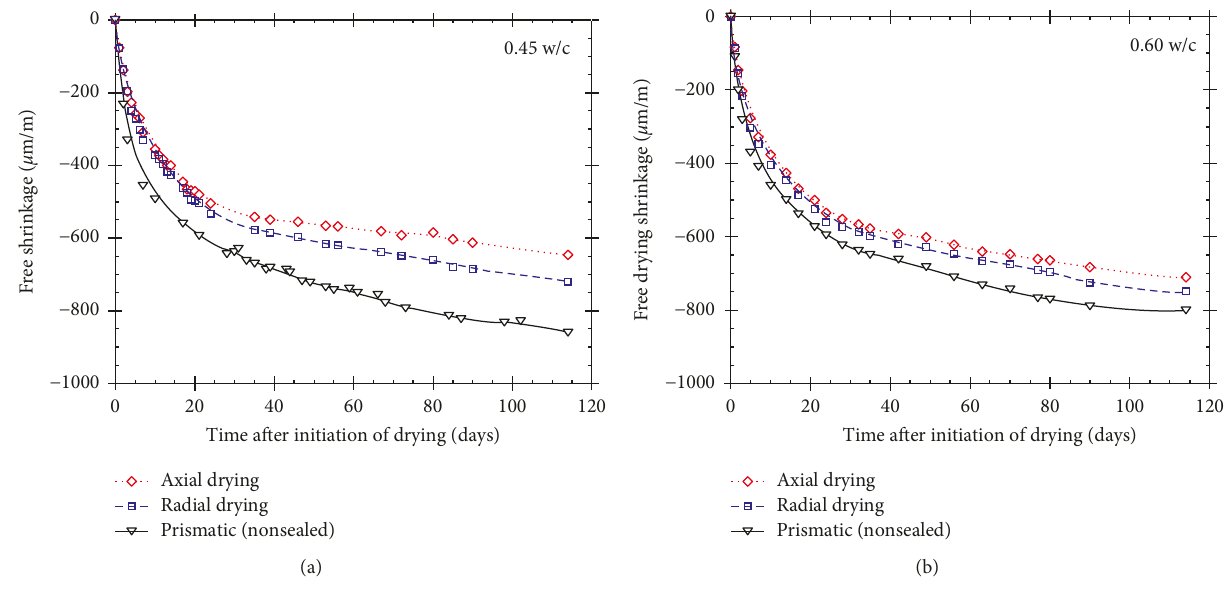
Figure 8: Influence of specimen geometry, S/V, and drying direction on free shrinkage recorded. (a) w/cm 0.45 mixture, (b) w/cm 0.60